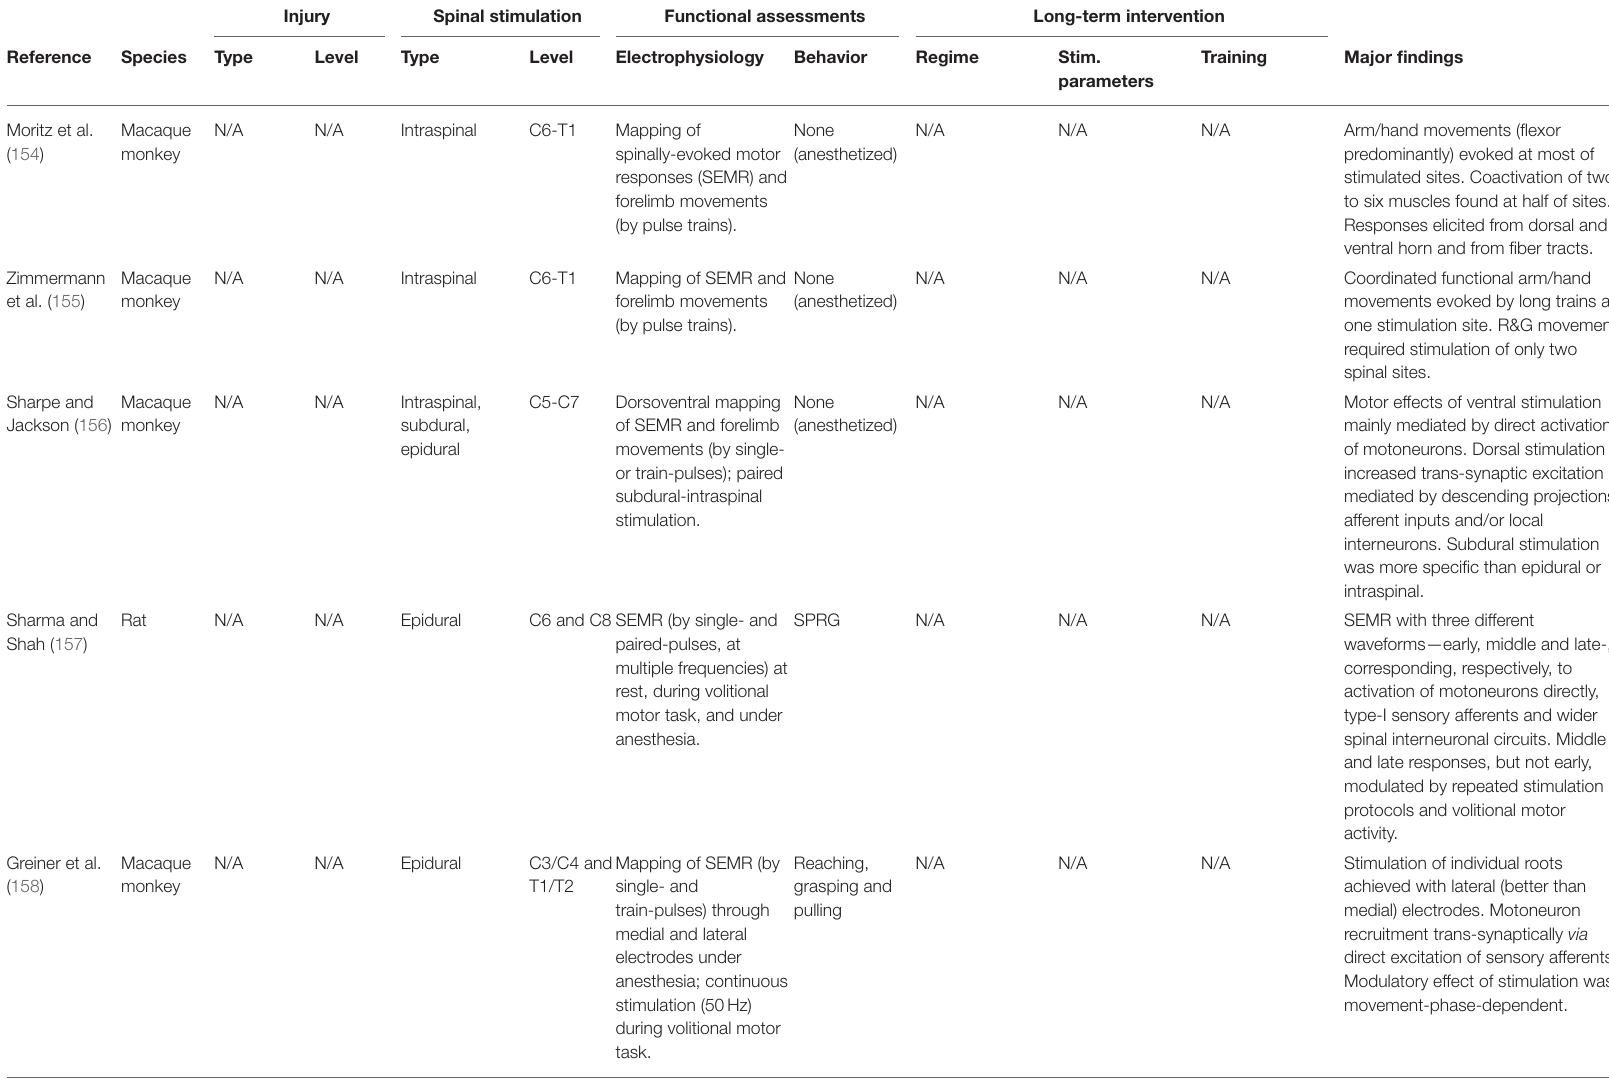
TABLE 1 | Summary of the most relevant animal studies on cervical spinal